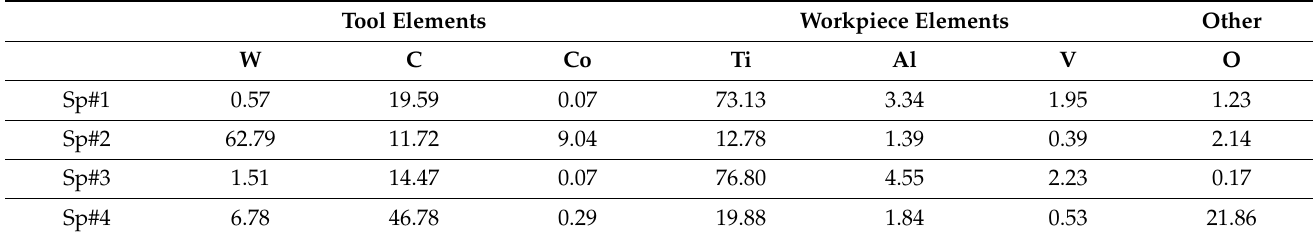
Table 7. EDS Spectral analysis of locations identified in Figure 18d.